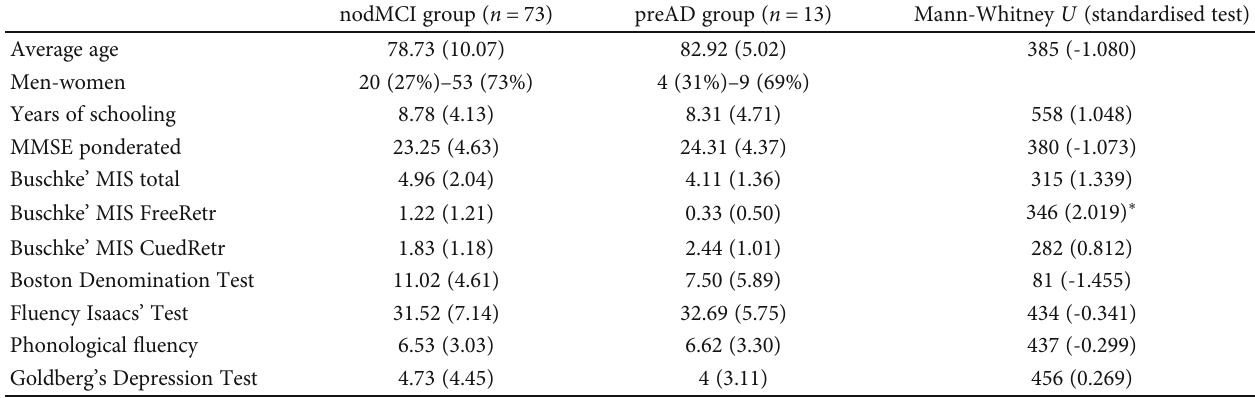
Table 1: Groups ’ characteristic mean (SD). Mann-Whitney U test (standardised